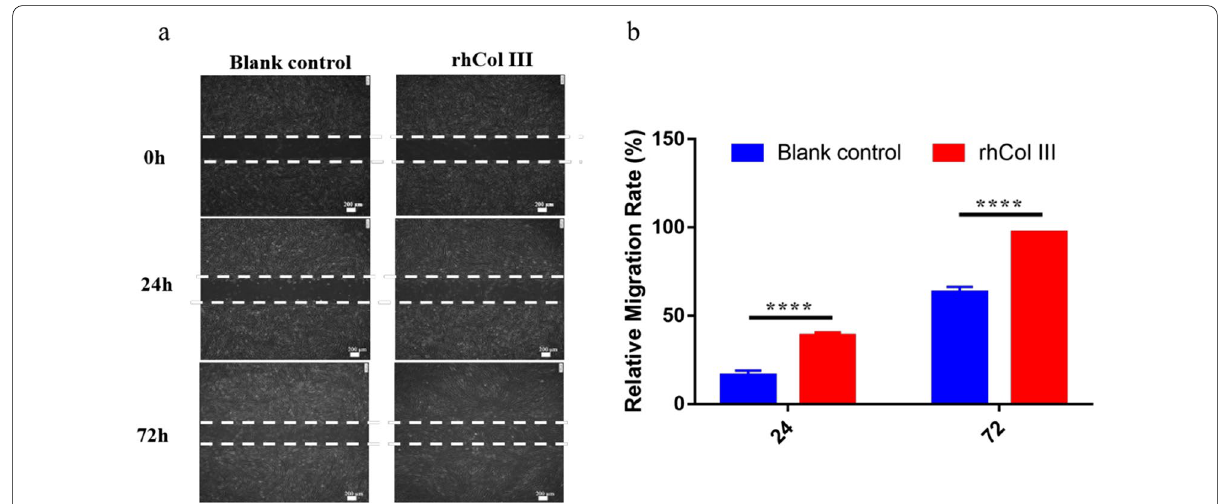
Fig. 6 Relative migration rate of HSF treated by rhCol III (paired T